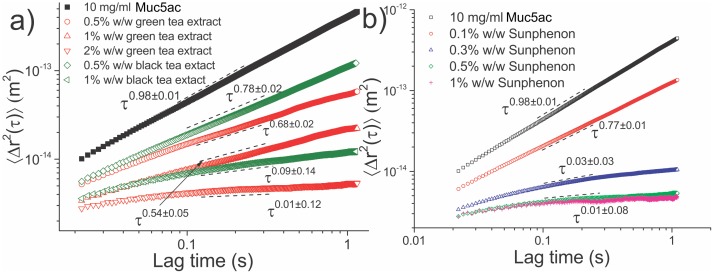
The ensemble averaged MSD curves obtained from a 10 mg/ml Muc5ac solution before and after the addition of (a) green and black tea extracts and (b) the EGCG-rich green tea extract Sunphenon 80SK.The addition of up to 1% w/w green tea extract caused the solution to become viscoelastic, whereas at 2% w/w the solution has undergone a sol-gel transition. Similarly, at 0.5% w/w black tea extract the solution is viscoelastic, whereas at 1% w/w the solution appears to have transformed into a weak gel. The addition of 0.1% w/w Sunphenon extract caused the purely viscous liquid to become viscoelastic, with a power law of 0.77±0.01. At a concentration of 0.3% w/w Sunphenon extract the solution undergoes a sol-gel transition, evident by the 0.03±0.03 power law exponent of the MSD curve. At 0.5% w/w Sunphenon there is an increase in the viscoelastic characteristics of the gel and no further change could be detected using PTM at higher concentrations.